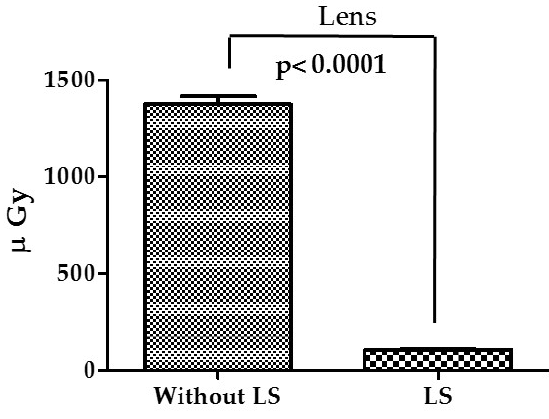
Figure 4. Radiation doses at the lens of the eye with and without lead shielding. AK and DAP values that were measured with different angiographic projections were reported in Table 4. DAP represents the radiation dose at the output of the X-ray tube, while AK represents the skin dose. Between the angiographic projections, it was found that LAO 40 CAU 30 led to the highest radiation dose (DAP = 652.1 ± 3.31 cGy∙cm 2 and AK = 117.30 ± 0.58 mGy). This is mainly because of the large area of irradiation asso- ciated with this angle. The radiation dose measured with LAO 60 is close to that of the LAO 40 CAU 30 angle, with its DAP and AK being 633.6 ± 5.62 cGy∙cm 2 and 114.1 ± 1.02 mGy, respectively. The angle associated with the lowest radiation dose was LAO 10 CRA 30; since this angle has a small angle of rotation, the irradiated area was also small, which resulted in a low radiation dose. Table 4. Dose-area product (DAP) and air kerma (AK) measurements for each angle of projection. Rotation